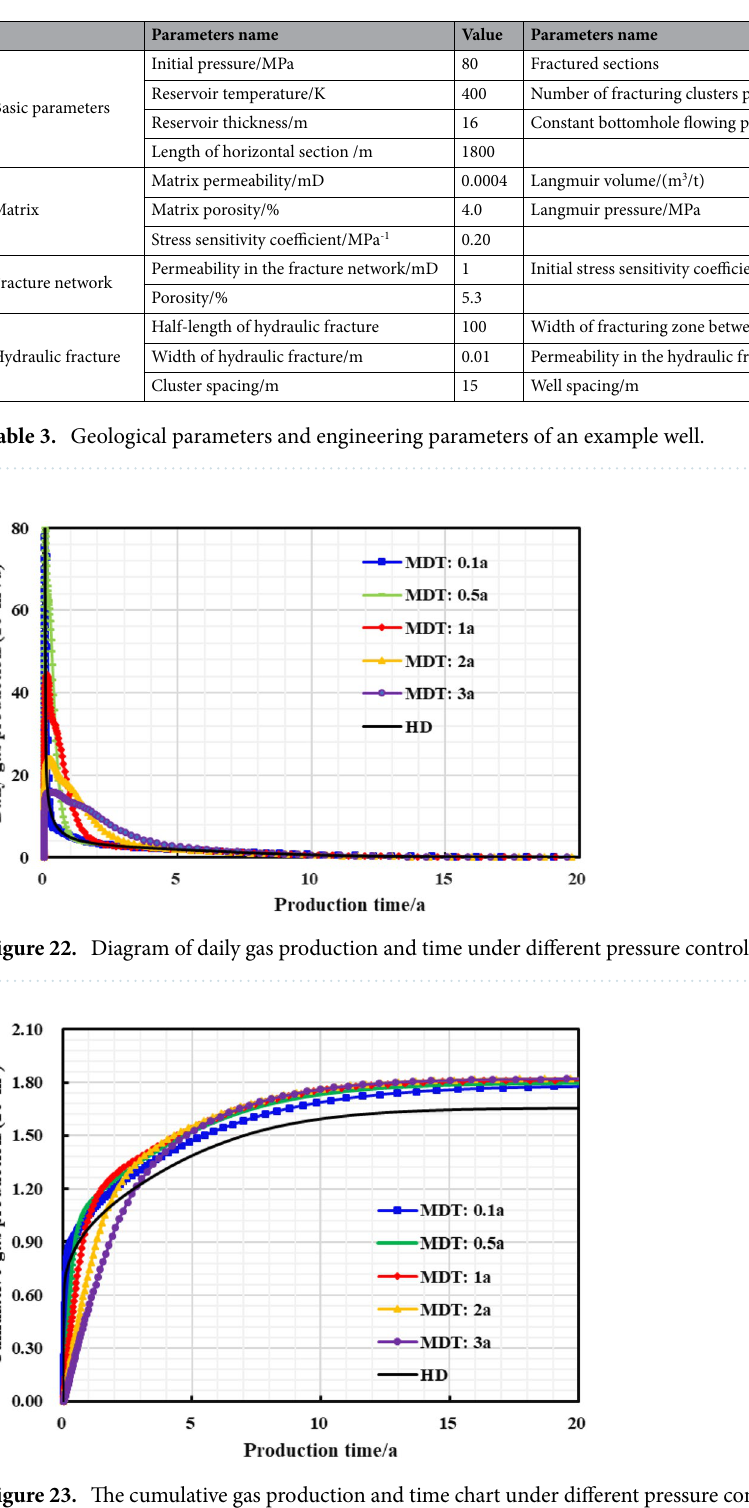
Figure 23. The cumulative gas production and time chart under different pressure control